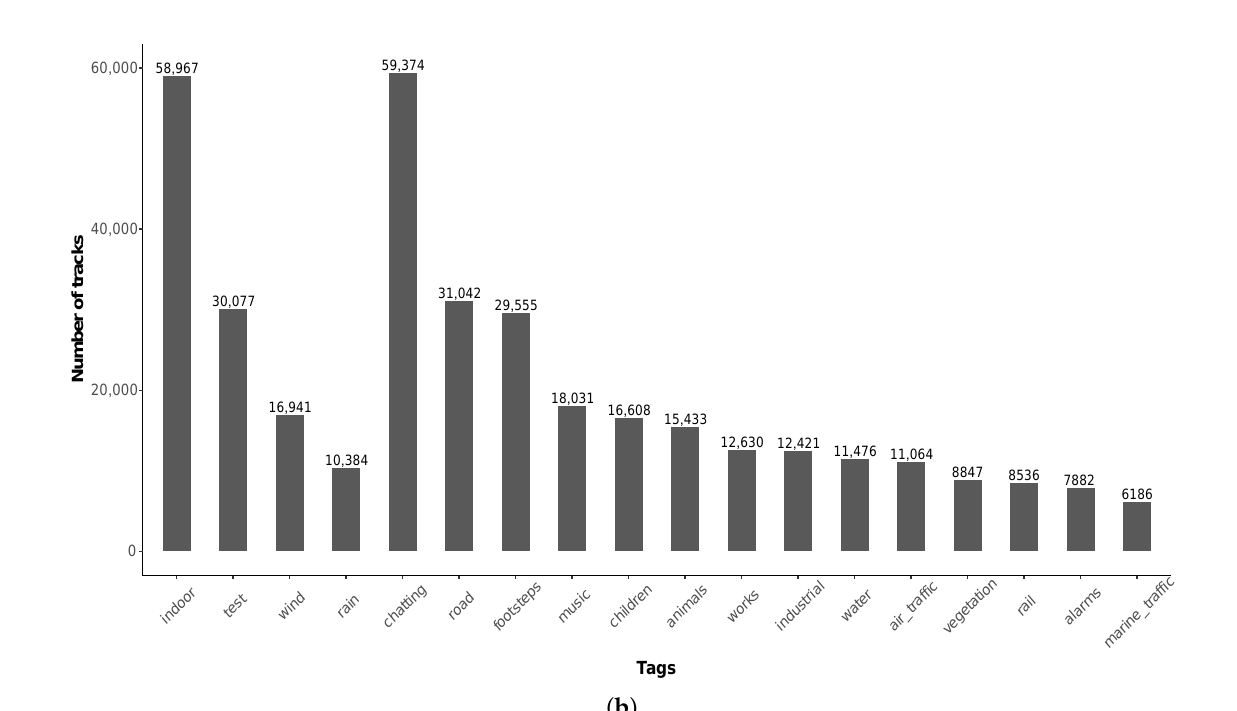
Figure 14. Use of soundscape tags by contributors. ( a ) Number of tags simultaneously used in a track. ( b ) Tags